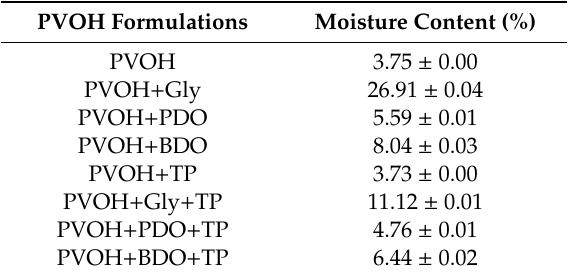
Table 2. The equilibrium moisture content (%) of PVOH-based formulations. The reported data are the mean values of three independent replicates with their standard deviations ( ±